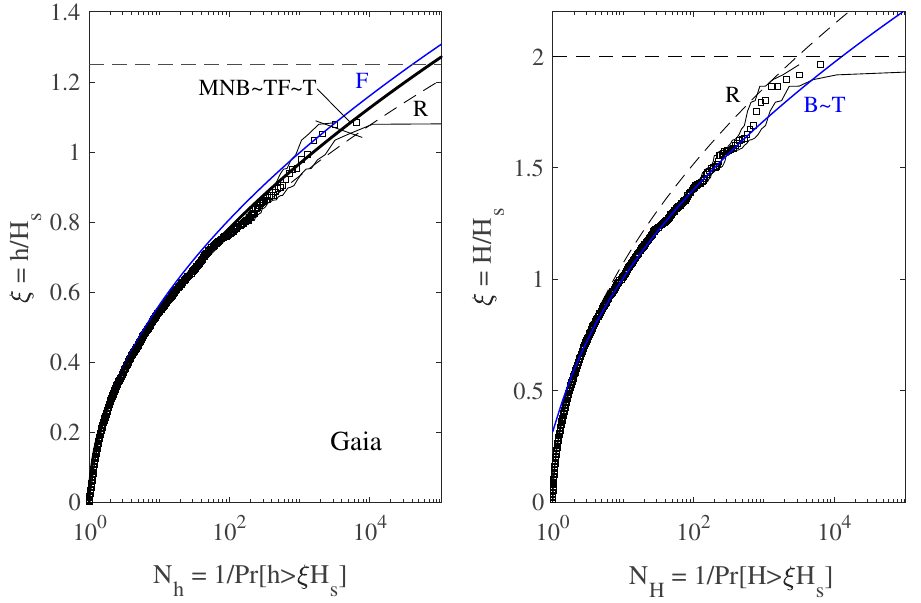
Figure 7. Wave statistics for storm Gaia: (left) crest heights h / H s and (right) crest-to-trough wave heights H / H s versus number of waves N h (ξ) . The empirical distribution (squares) from the observed wave ensemble is compared against with theoretical models: T = Tayfun 23, 25 , TF = Tayfun-Fedele 24 , MNB = modified narrow- band 41 , B = generalized Boccotti 42 , F = Forristall 43 and R = Rayleigh distributions. Confidence bands are also shown (light dashes). N h (ξ) is the inverse of the exceedance probability Pr similarly N H (ξ) is for crest-to-trough heights. Horizontal lines denote the rogue threshold 1.25 H s and 2 H s for crest and wave heights 2 .